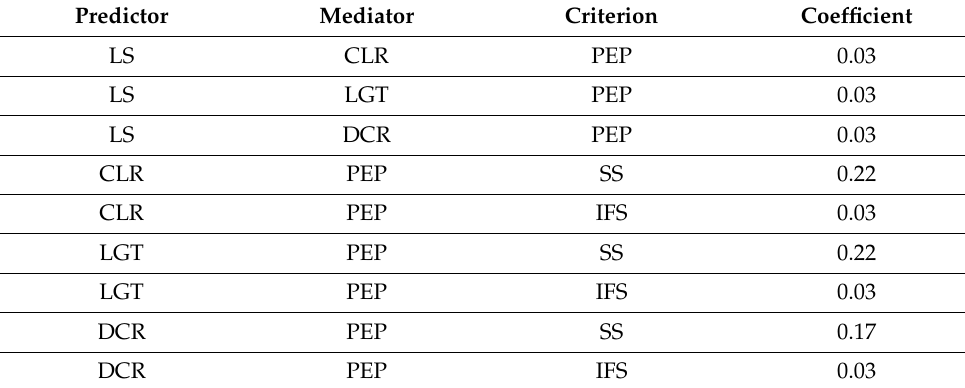
Table 4. Indirect effects among significant